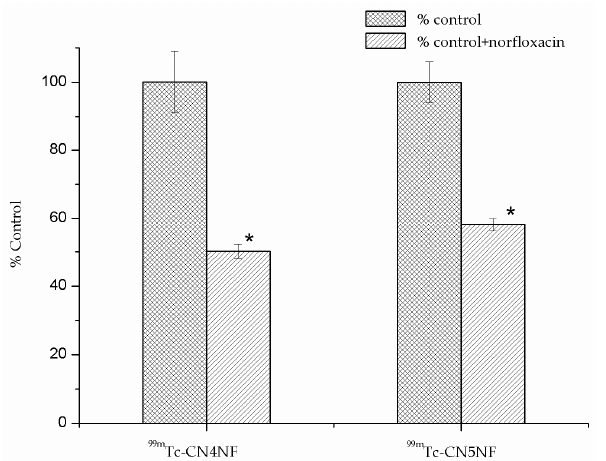
Figure 3. In vitro binding of [ 99m Tc]Tc-CN4NF and [ 99m Tc]Tc-CN5NF. n = 6, * p < 0.05.